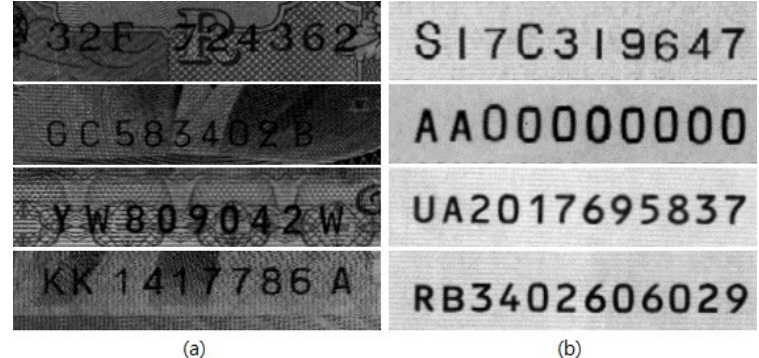
Figure 2. Examples of the backgrounds of serial number regions: ( a ) serial numbers with complex background patterns; ( b ) serial numbers with clean background patterns